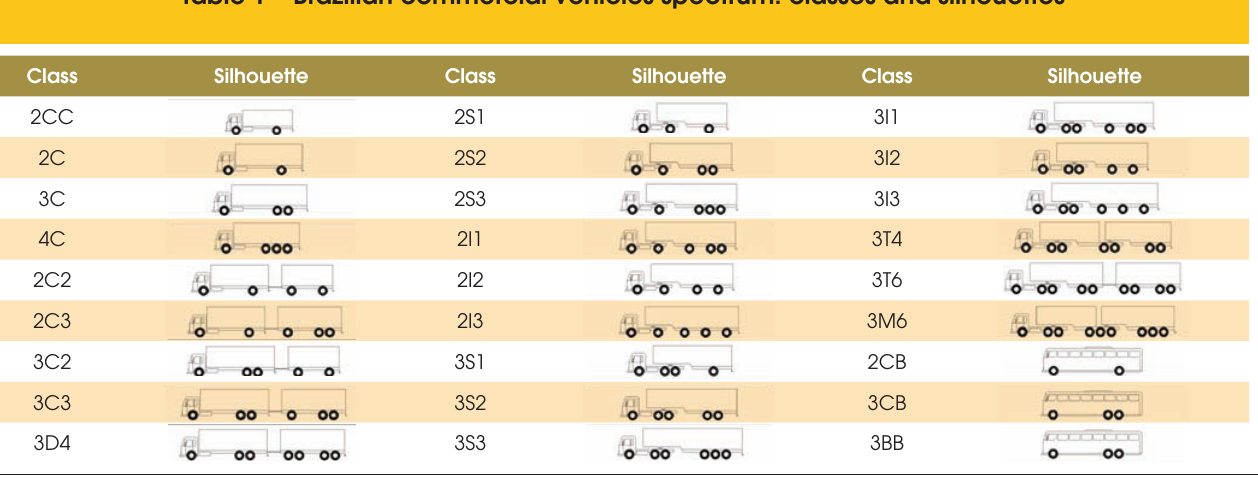
Table 1 – Brazilian commercial vehicles spectrum: classes and